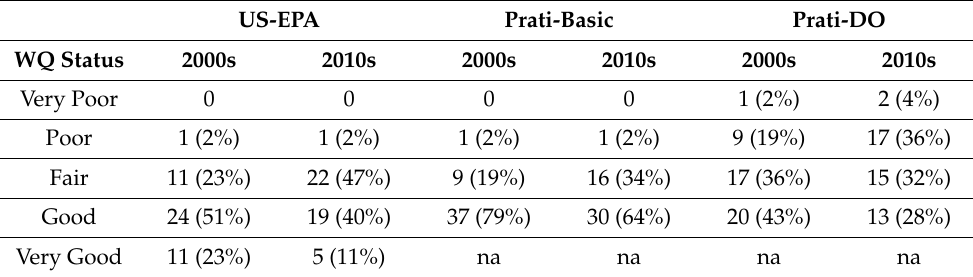
Table 5. Number (and percentage) of sites by water quality status in the 2000s and 2010s.